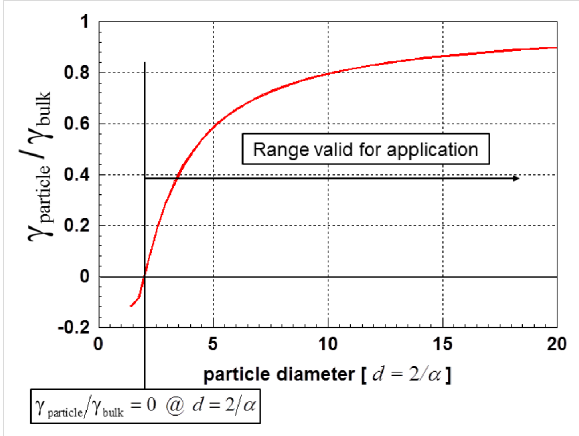
Figure 4: Graph of Equation 6. Also in this case, a lower limit for the particle diameter exists ( α = β = 1).